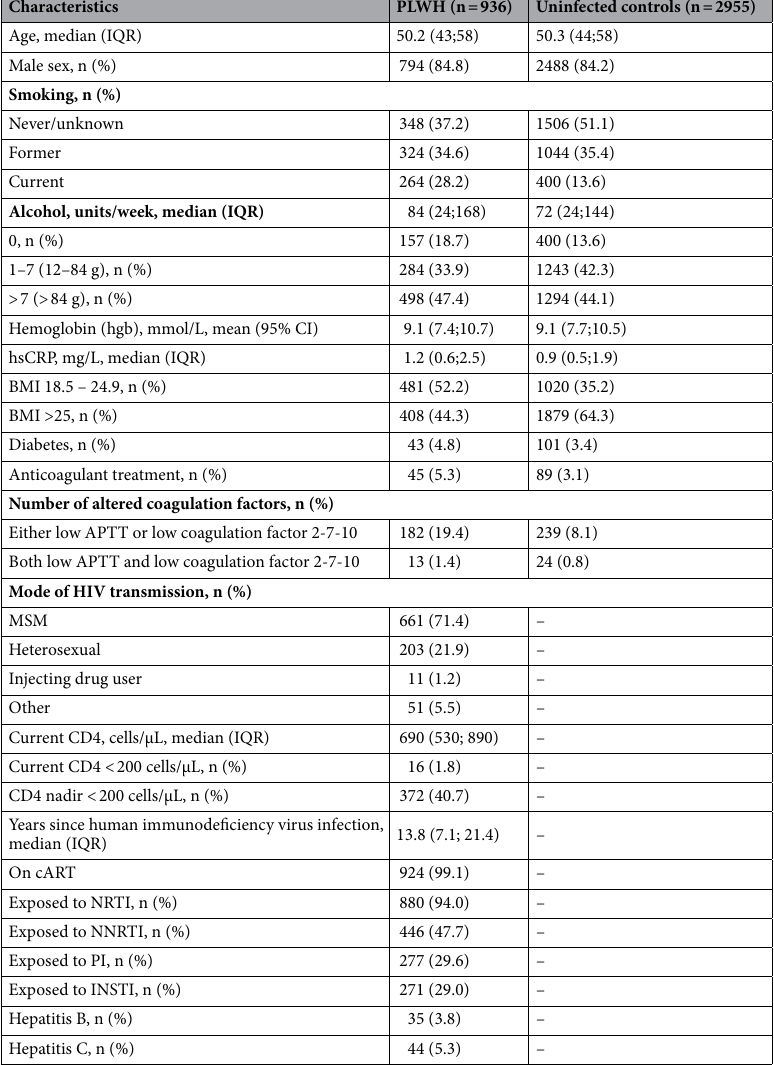
Results from multi- variable logistic analyses are shown in Table 2. HIV was independently associated with short APTT (aOR 2.2 (95% CI 1.7; 2.9), P = < 0.001) after adjusting for age, sex, smoking status, alcohol use, BMI, diabetes and hsCRP. Further, higher age, alcohol consumption and BMI > 25 kg/m 2 was associated with short APTT. In contrast, HIV was not independently associated with prolonged APTT. In multivariable analysis, HIV was independently associated with low coagulation factor II–VII–X concen- trations (aOR 1.4 (95% CI 1.0; 1.8), P = 0.042). Furthermore, higher age and BMI > 25 kg/m 2 were associated with low coagulation factor II–VII–X concentrations, while male sex was associated with low coagulation factor II–VII–X concentrations. In a sensitivity analysis, including only PLWH without HCV or HBV, HIV was still